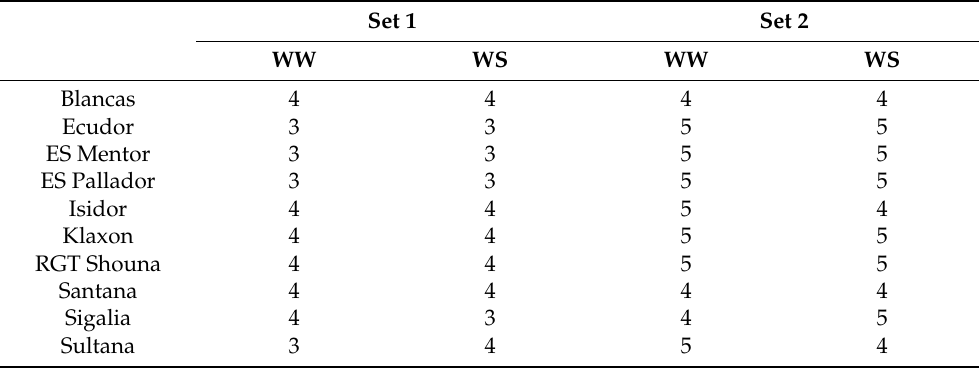
Figure A1. Volumetric soil water content (%) of well-watered (closed circles) and water-stressed (open circles) treatments for 10 days after sowing. Values are mean ( n = 80) ± standard error. Table A1. Number of replications within each set and for the two contrasting soil moisture status; well-watered (WW) or water-stressed (WS) conditions (experiment under controlled conditions).